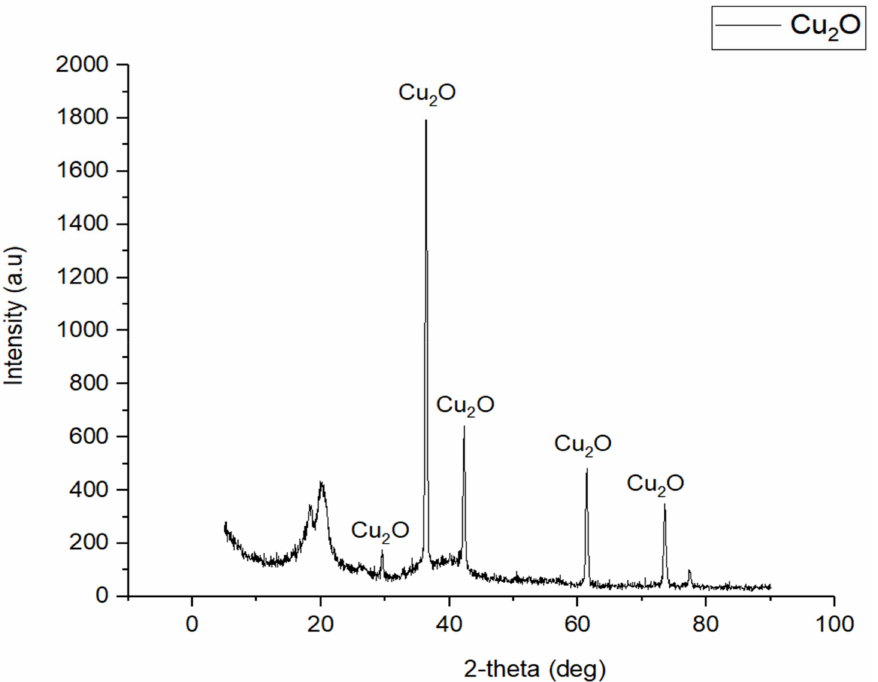
Figure 3. XRD graph for 0.5 Cu 2 O/PVDF DLHF membrane with 6 mL/min outer dope extrusion flowrate.